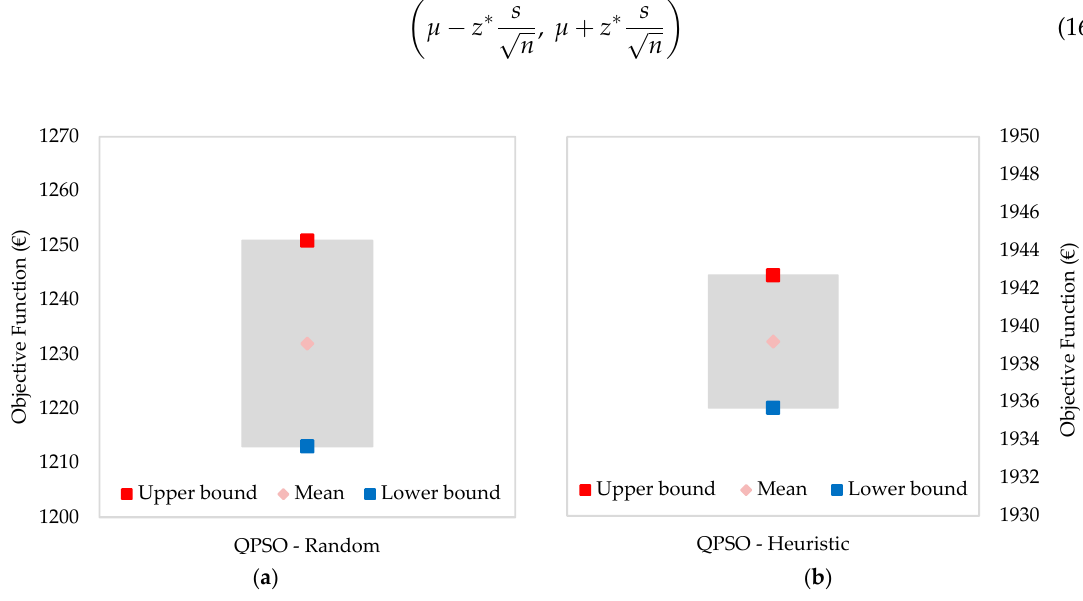
Figure 3. Confidence interval of 95% confidence for QPSO, for: ( a ) randomly generated initial solution; ( b ) initial solution based on the proposed heuristic